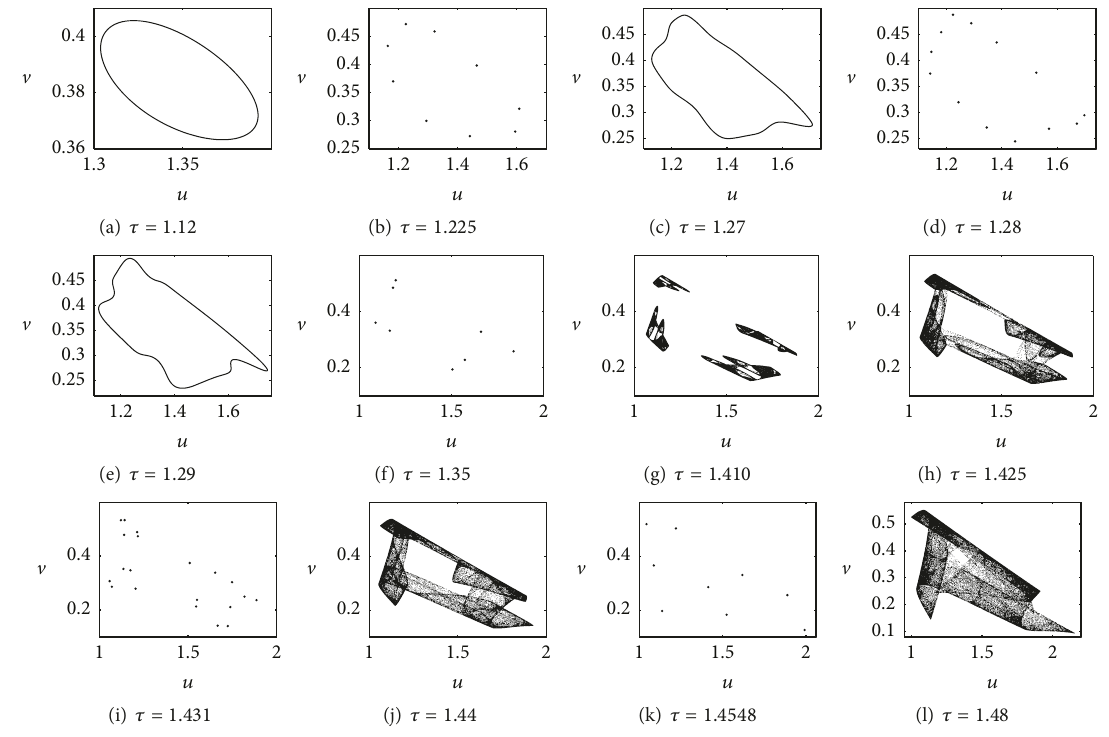
Figure 4: Phase portraits for various values of 𝜏 corresponding to Figure 3(a).